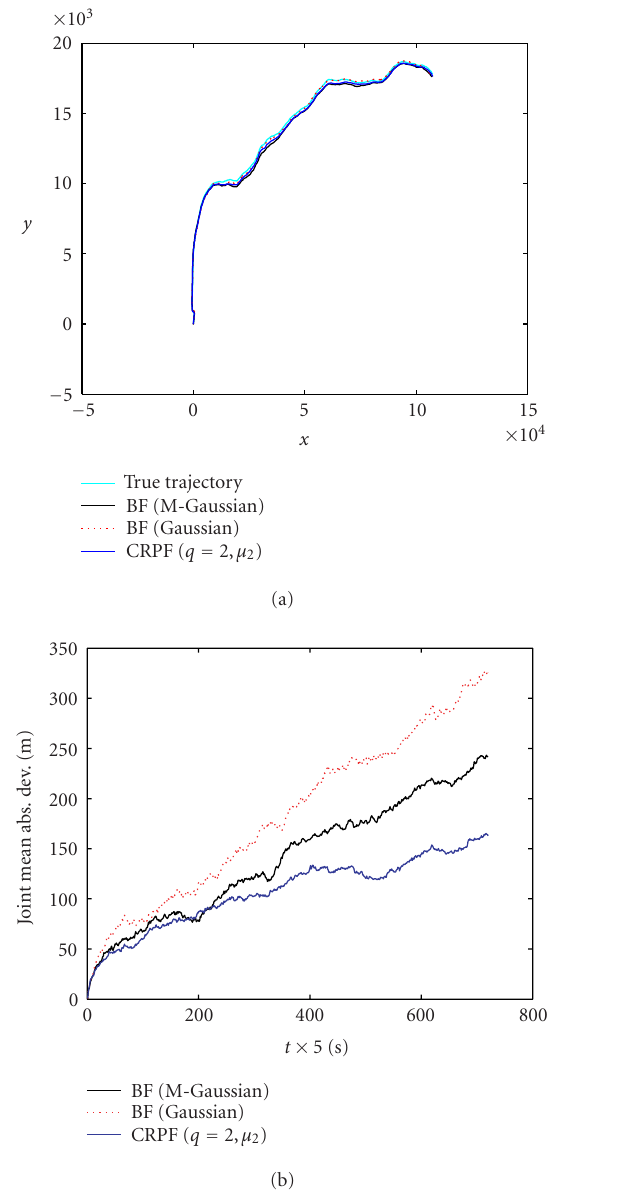
Figure 7: Local versus multinomial resampling. T s = 5 seconds. (a) Trajectory. (b) Mean absolute